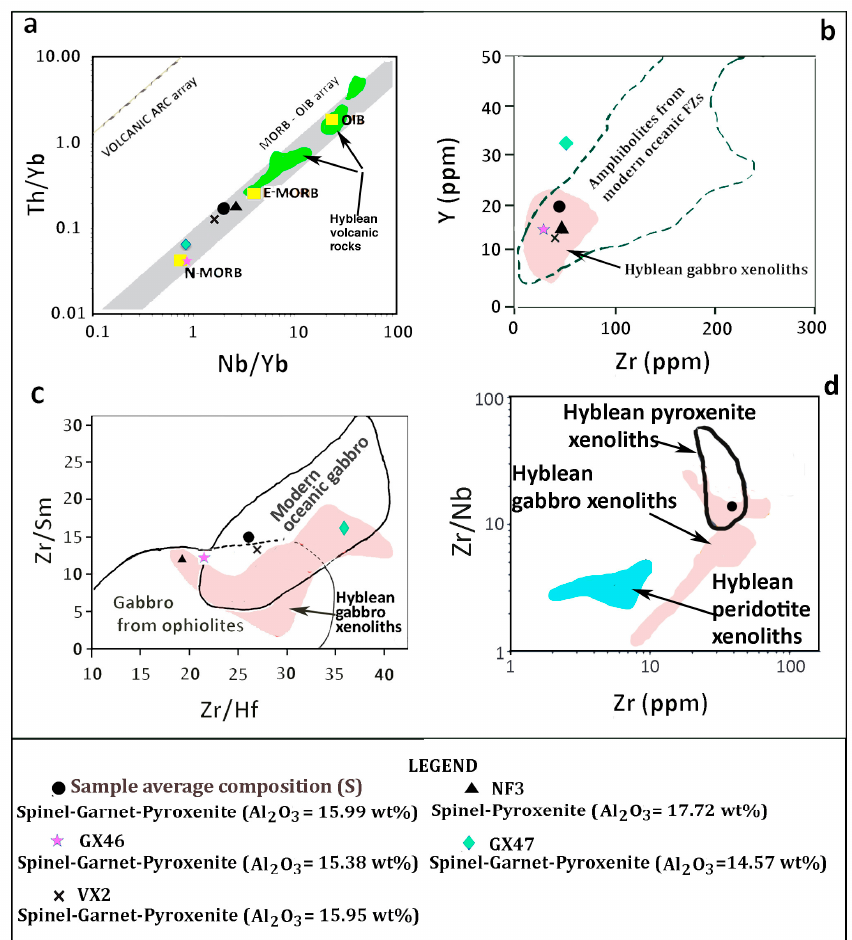
Figure 8. Variation diagrams of different trace elements and element ratios providing information on the geochemical affinity of the sample (S) and other high-Al pyroxenite xenoliths from the Hyblean area. ( a ) Nb/Yb vs. Th/Yb diagram. The sample plots in the “oceanic array” [63]. ( b ) Zr/Y diagram. The sample plots in the field of amphibolites from modern oceanic fracture zones (FZ) [64]. Field of Hyblean gabbroic xenoliths after [17]. ( c ) Zr/Hf vs. Zr/Sm diagram. The sample plots in the overlapping zone between fields of modern oceanic gabbros and gabbros from ophiolites [64]. ( d ) Zr vs. Zr/Nb diagram. The sample plots in the overlapping area between the field of Hyblean pyroxenite xenoliths and Hyblean gabbroic xenoliths [17,45]. Sample composition: this work. High-Al pyroxenite xenolith compositions after [40] and [42]. The multielement diagram reported in Figure 5c indicates that some incompatible elements, especially Cs, Ba and U, are significantly enriched with respect to PM values. Such an enrichment is probably due to the modal abundance of kelyphite, which is enriched in incompatible elements, especially the fluid-mobile ones (Figure 5a). The circumstance that the “sub-sample” S1 (see previous section) has undetectable amount of Cs and lower Rb and Ba than other “sub-samples” (Figure 5c), probably depends on the heterogeneous modal distribution of garnet, hence kelyphite, in the whole rock. The chondrite-normalized REE pattern (Figure 6) is compatible with the composition of some MORB types, particularly those formed in slow-spreading settings, such as South Mid-Atlantic Ridge [62] and references therein reported. In summary, texture, modal and chemical compositions of the sample, as well as of other Hyblean garnet-bearing pyroxenites, may lead to different, even conflicting, interpretations. The low content in Cr (and in other transition elements) and the relatively high content in incompatible